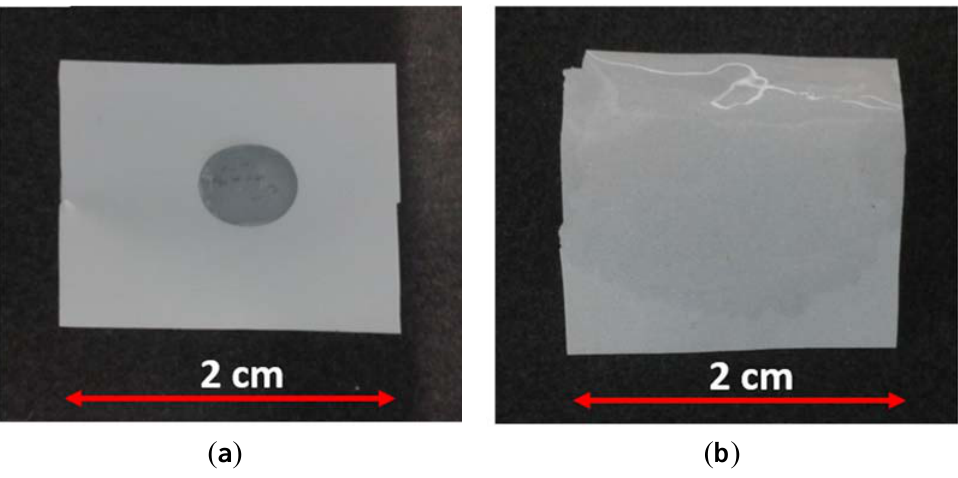
Figure 3. Images of membranes subjected to the wettability test. The pictures were taken 2 s after dropping 80 µL of electrolyte on the ( a ) commercial polyethylene (PE) single layer separator and ( b ) SiO 2 –HPG